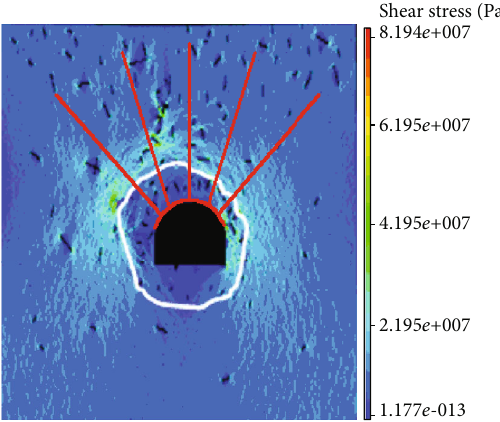
Figure 12: Test diagram of the roadway surrounding broken rock